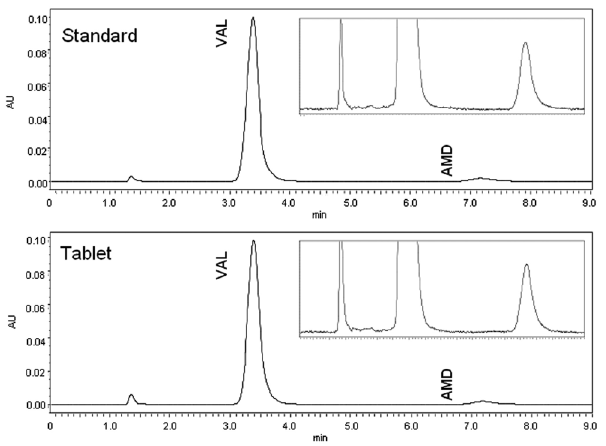
FIGURE 2 - Representative chromatograms obtained from standard and tablet solutions of AMD and VAL (concentrations of AMD and VAL of 1.25 and 40 µg mL -1 , respectively) Conditions: Phosphate buffer (pH 3.6, 0.01 M):acetonitrile:methanol (46:44:10 v/v/v), 1 mL min -1 flow rate, 240 nm UV detection.